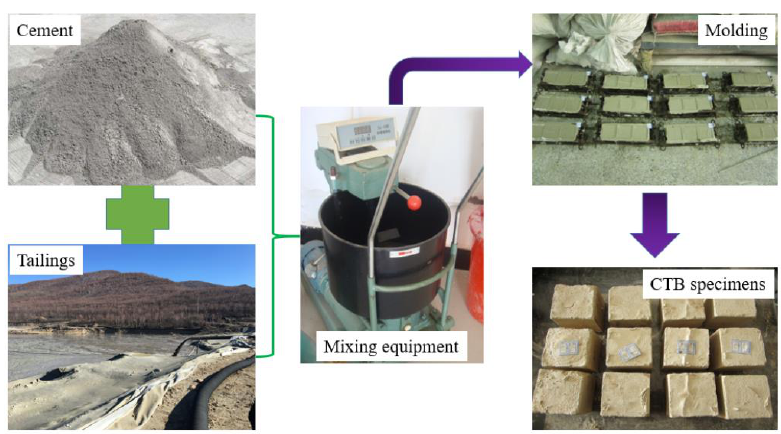
Figure 2. Some images of CTB sample preparation process.